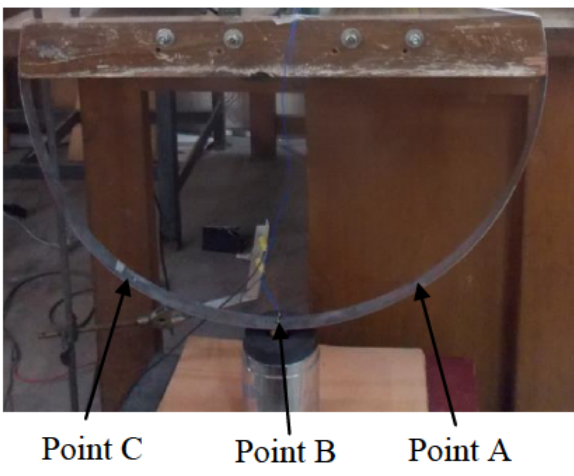
Figure 2: Photograph of curved beam with exciter.